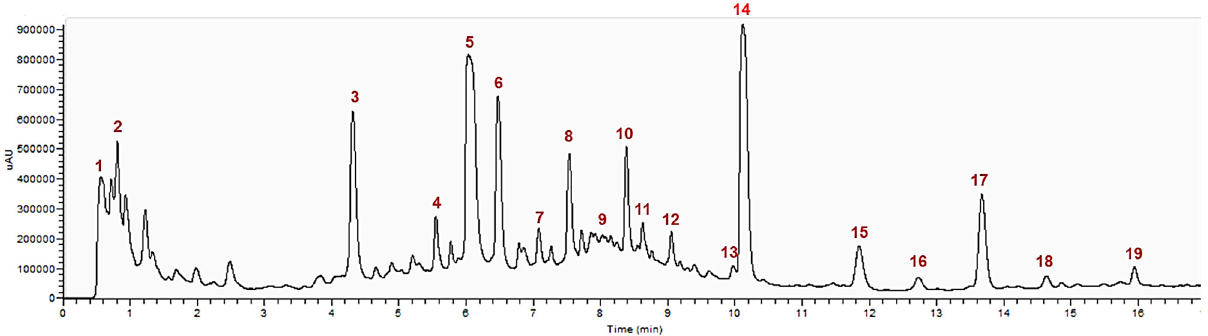
Figure 2. HPLC-PDA profile chromatogram of aqueous extract of S. nigra flowers. Time of retention is expressed in